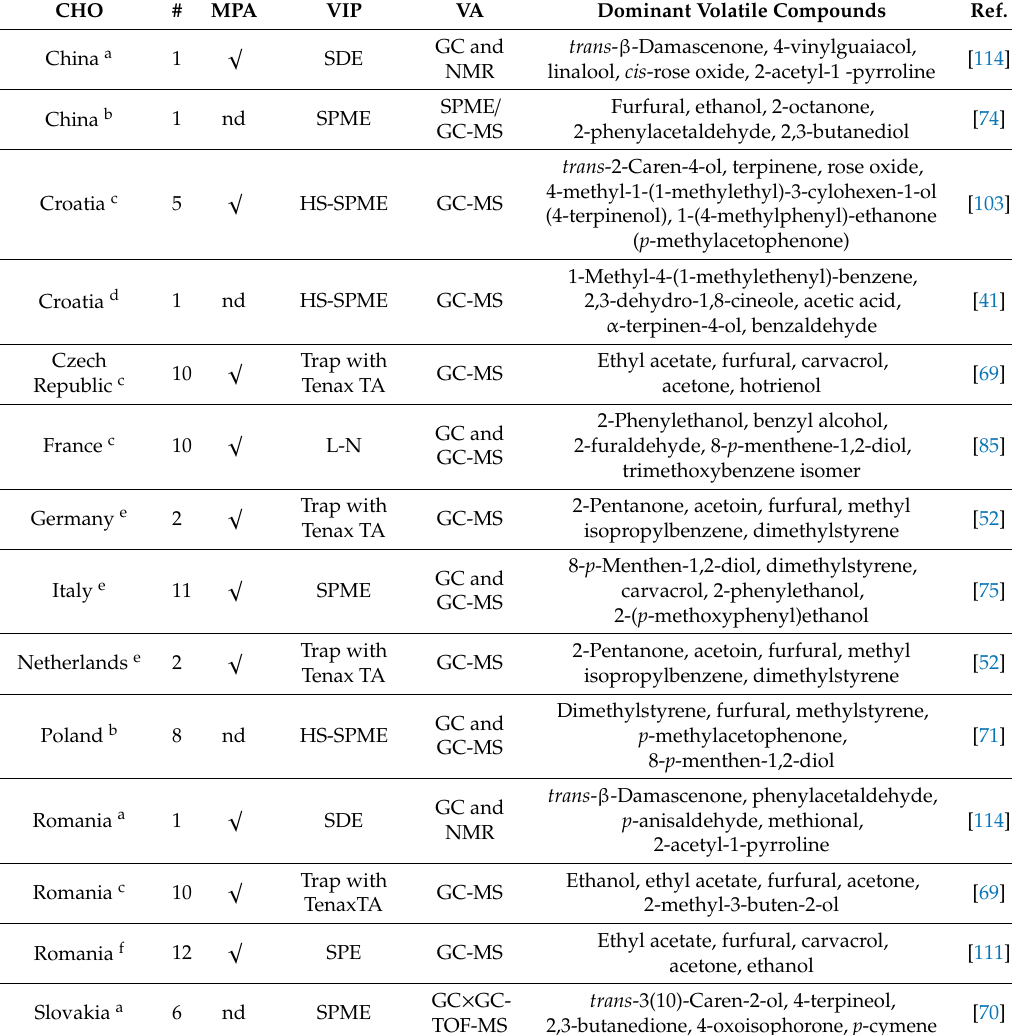
Table 12. Lime tree honey’s main volatiles, with reference to the country of origin, number of samples, isolation and analysis procedures and five main volatile components. Unless otherwise specified, the honeybee type was A. mellifera